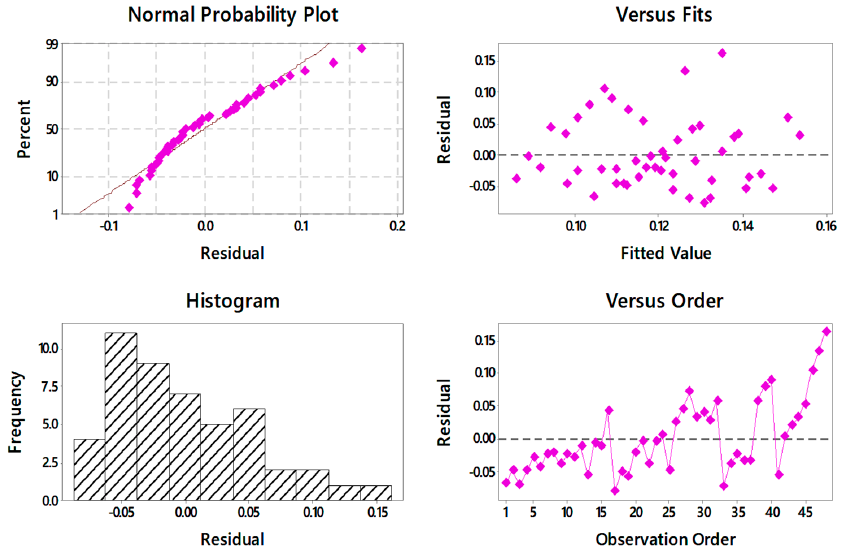
Figure 5. Plots of the residuals for TFPI.